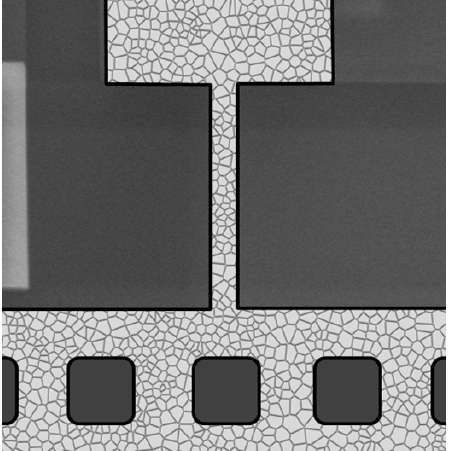
Figure 4. Example of the digital polysilicon morphology in the beam